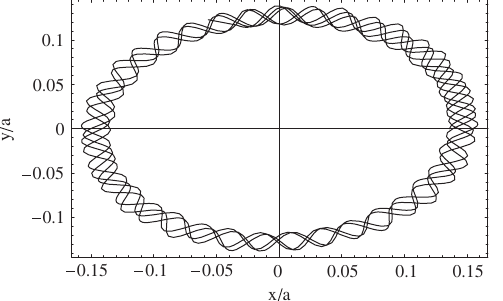
FIG. 1. Trajectory in (x,y) plane with initial conditions corre- sponding to the equilibrium r ð 0 Þ ¼ r λ